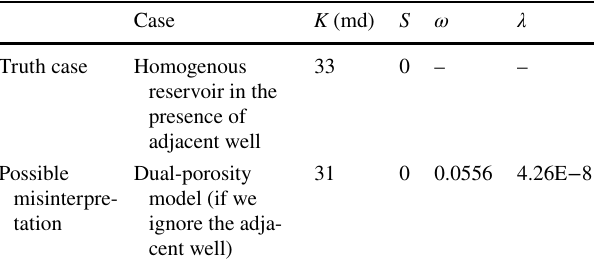
Table 3 Parameters obtained from the truth model and possible mis-